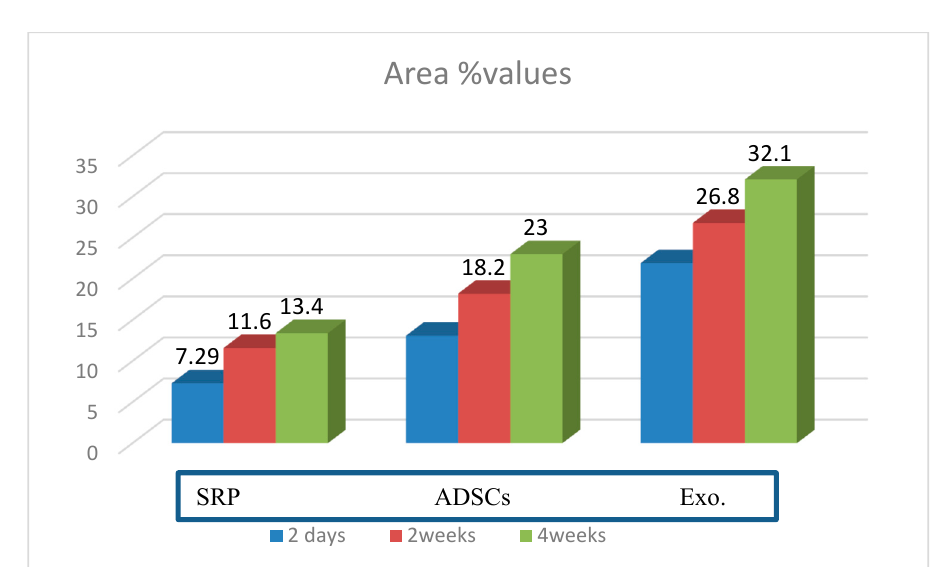
Figure 5. Bar chart showing area percent values of the studied groups after different time intervals.